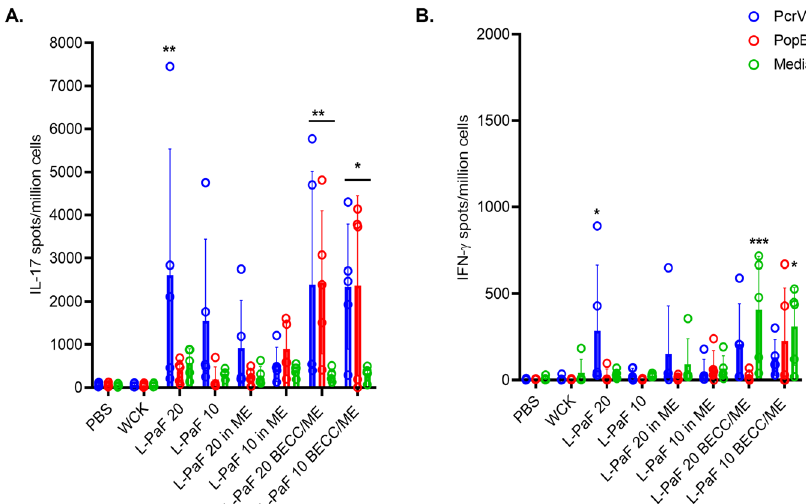
Fig. 3 IL-17 and IFN- γ secretion following ex vivo stimulation of lung cells. Cell suspensions were prepared and treated with either PcrV or PopB or left untreated (media). IL-17 ( A ) and IFN- γ ( B ) secreting cells were quanti fi ed after 24 h stimulation and are shown as secreting cells per million total cells. Values were plotted as individual points ± SD ( n = 5/group). Error bars represent SD. Statistical signi fi cance was calculated by comparing PBS vaccinated group with each of the other vaccinated groups using Dunnett ’ s test. * p < 0.05, ** p < 0.01, *** p < 0.001.